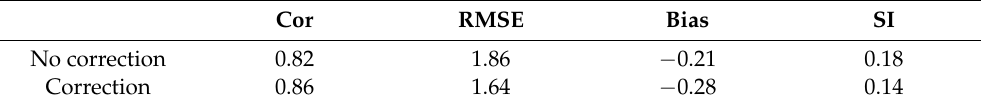
Table 3. Performance of residual amplitude error correction on wind speed retrieval.